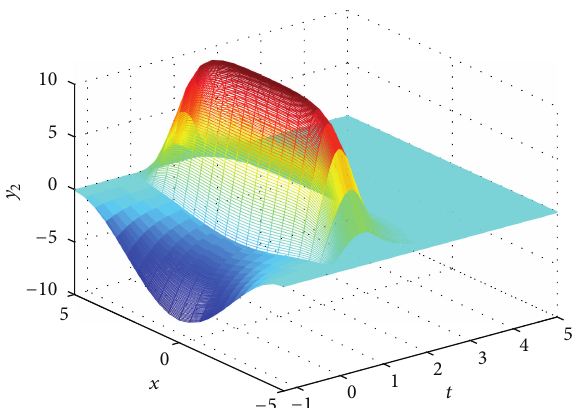
Figure 2: The dynamical behavior of the subsystem 𝑦 2 of system (36).